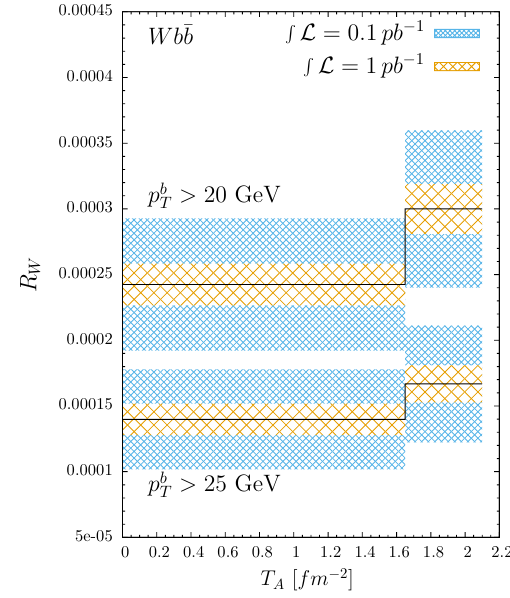
Fig. 7 The ratio R W as a function of T for Wb ¯ b final state integrated in bins of T A for two values of the integrated luminosity and different cuts on jet transverse momenta